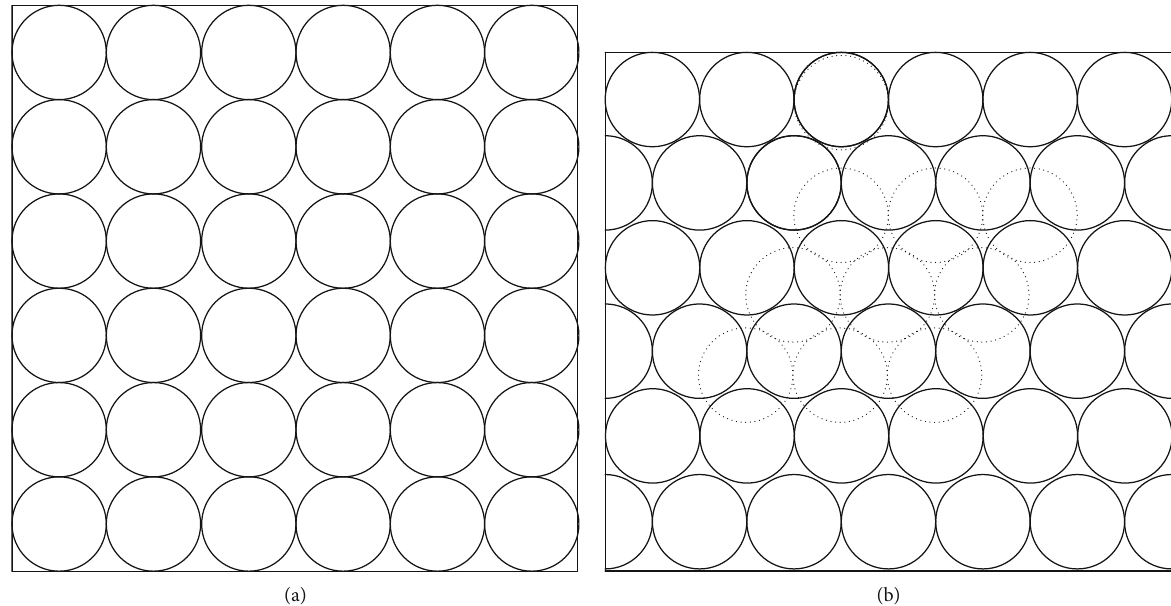
Figure 1: Schematic illustration of packing of single-size spheres: (a) loosest state and (b) densest